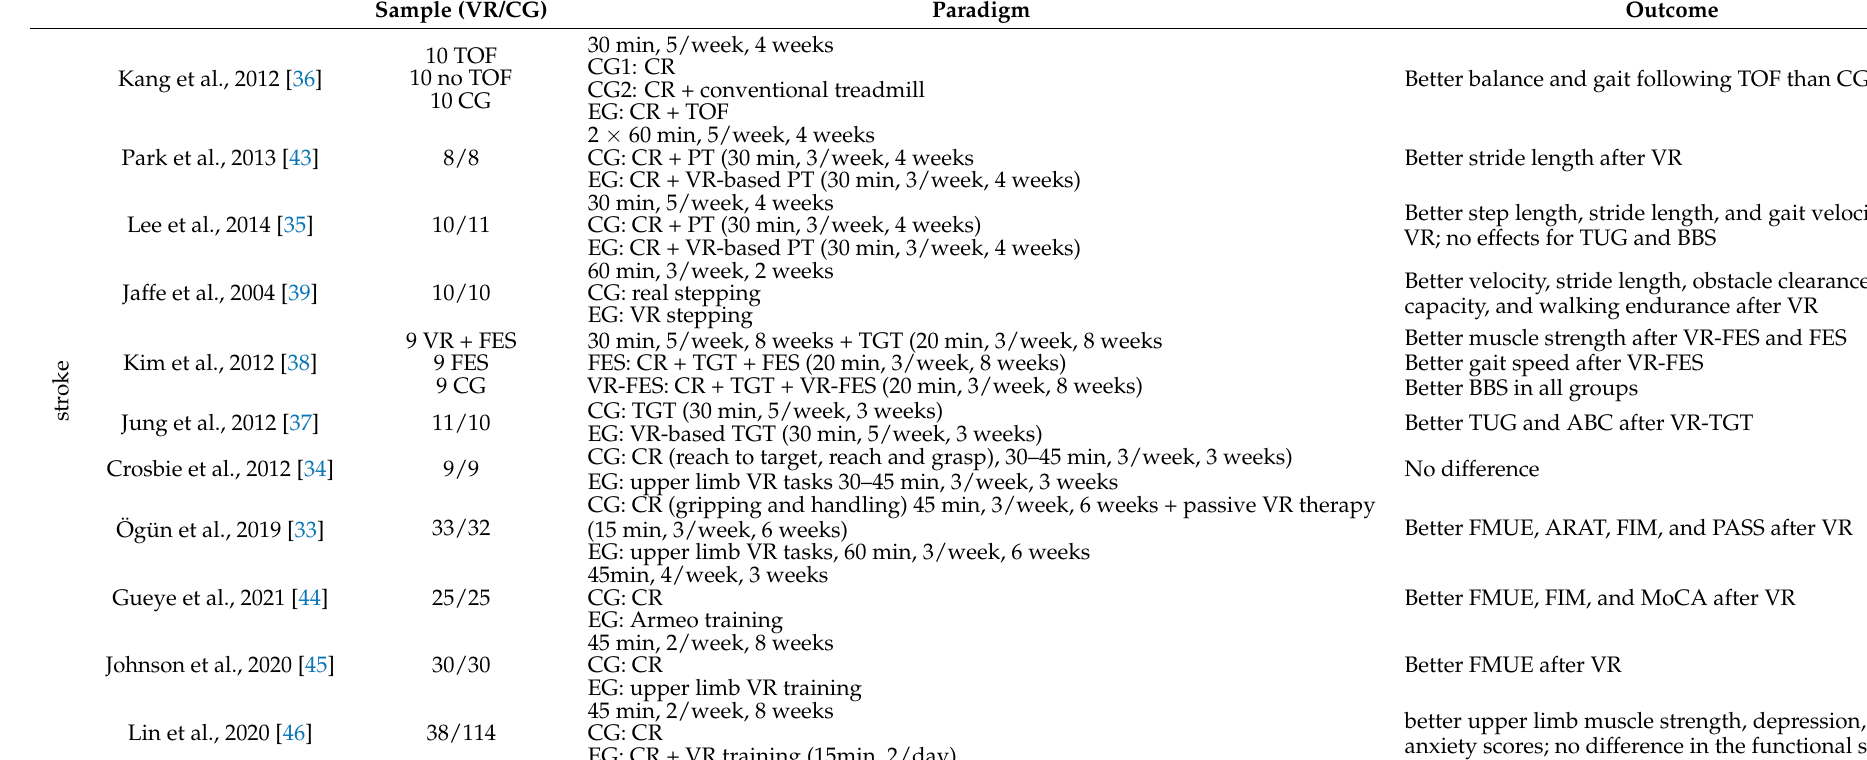
Table 1. Summary of reviewed articles. Legend: BBS, Berg balance scale; CR, conventional rehab; HC, healthy control; PT, postural control exercises; TGT, treadmill gait training; TOF, treadmill walking with optic flow; TUG, Timed Up-and-Go Test; FTD, frontotemporal dementia; MDD, major depressive